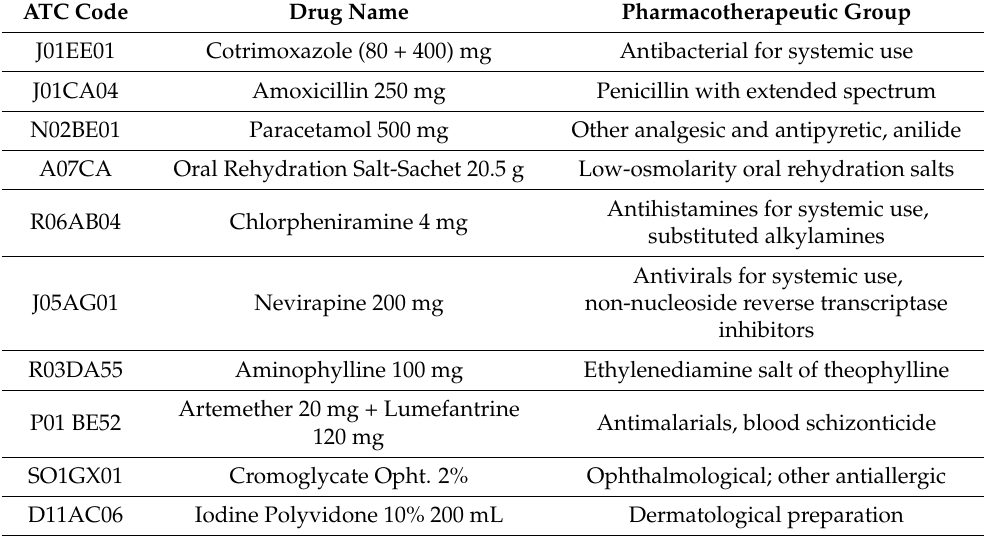
Table 1. Description of selected essential medicines.